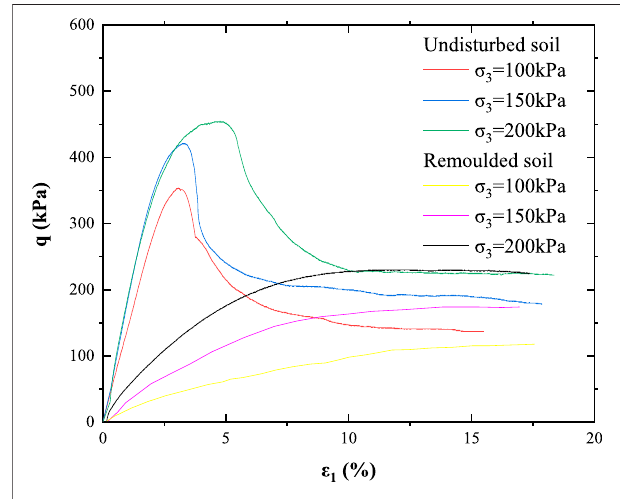
FIGURE 3 | Relation between shear stress and axial strain.